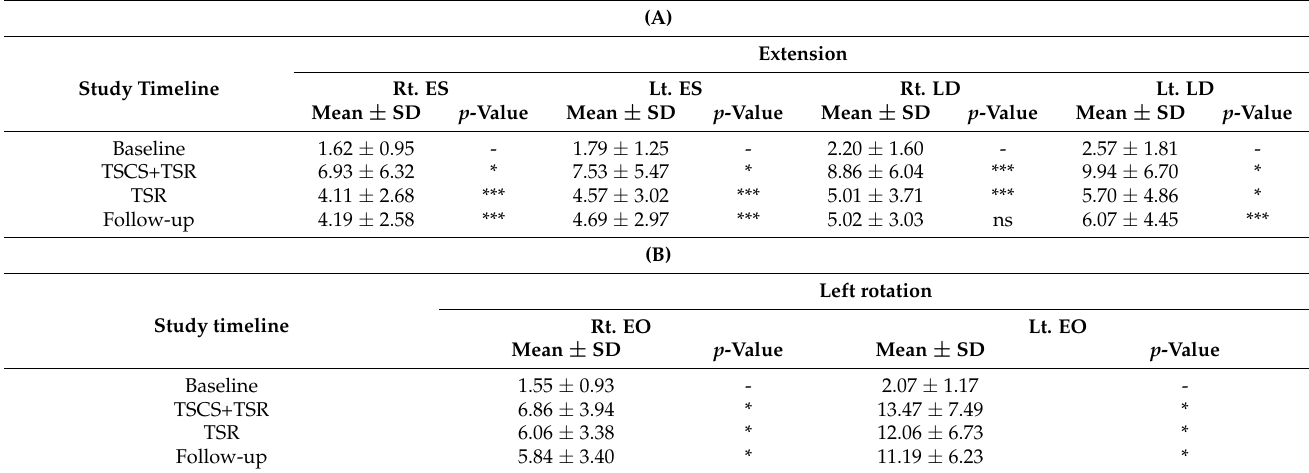
Table 2. The responses recorded from trunk muscles measured through